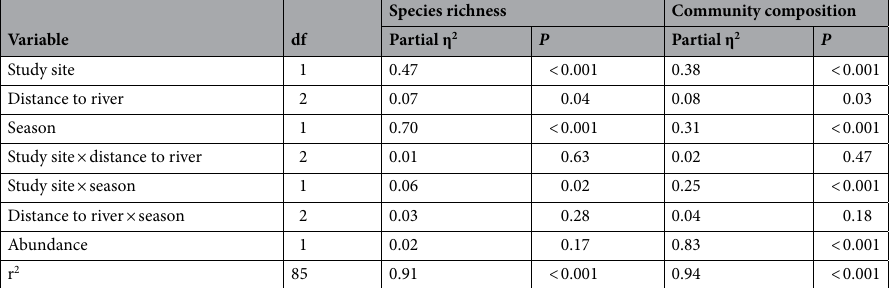
Table 2. General linear modelling identified differences between study sites, transect distance to river bed, and season with respect to butterfly species richness and community composition (assessed by the dominant eigenvector of a principle component analysis of the species × transect matrix). Number of records (abundance) served as metric covariate.